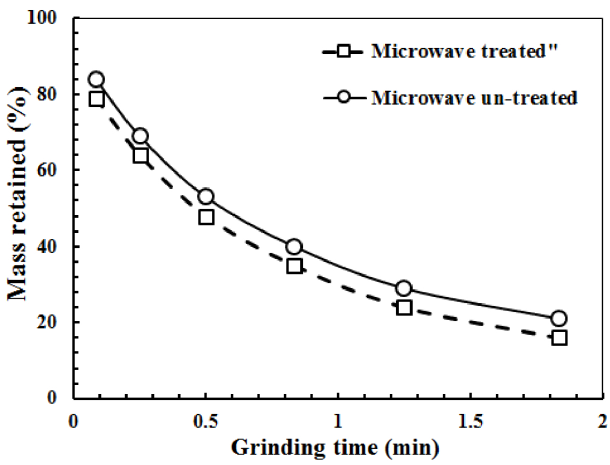
Fig. 5. The influnce of mass retained with grinding time for -1700+ 1180 µm fraction.